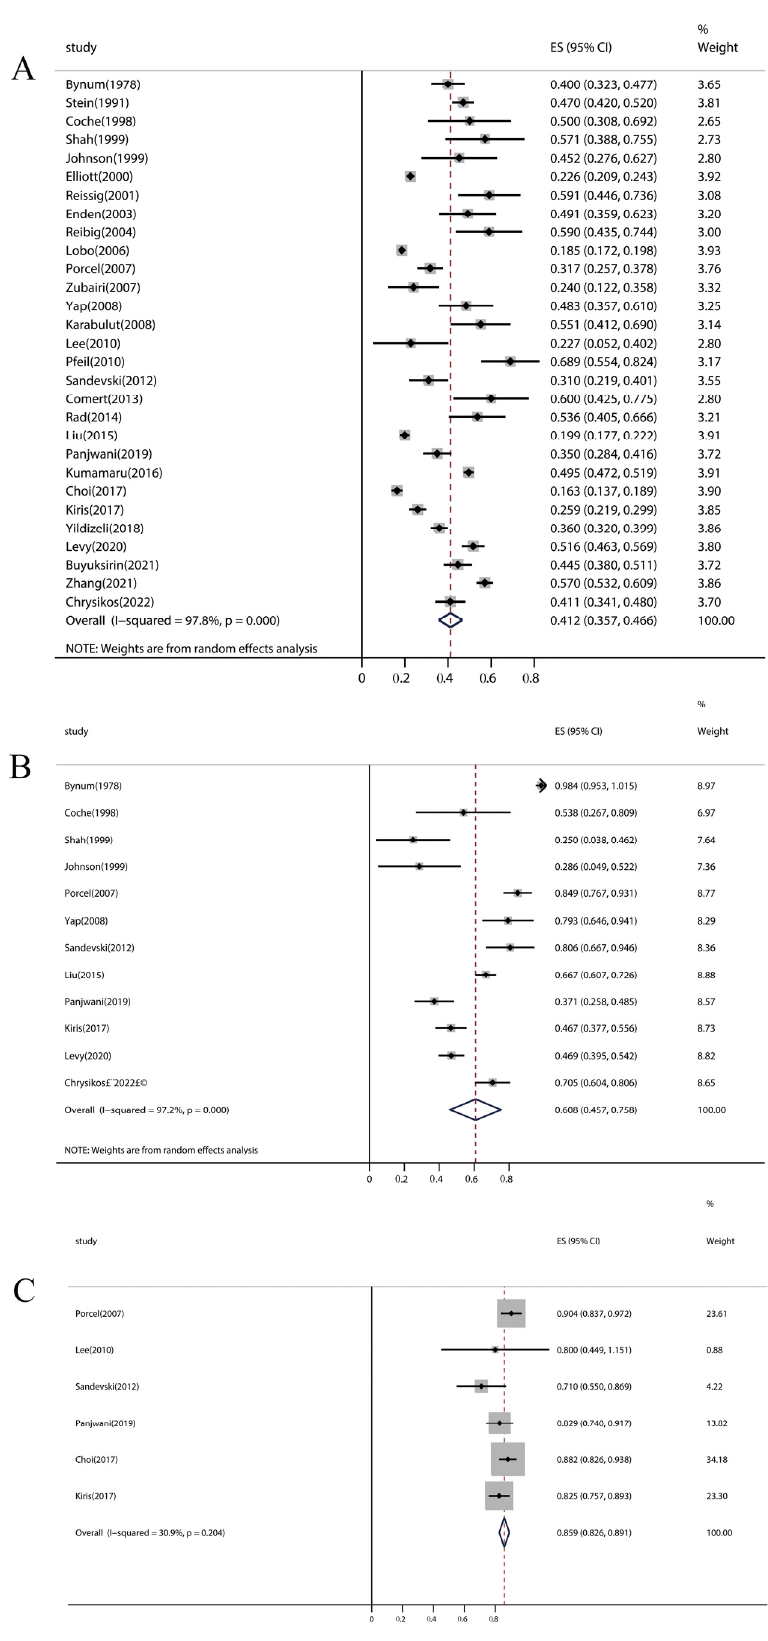
Figure 2. Forest plot of pleural effusion incidence in PE patients. ( A ) Incidence of pleural effusion. ( B ) Incidence of unilateral pleural effusion. ( C ) Incidence of small pleural effusion. PE, pulmonary